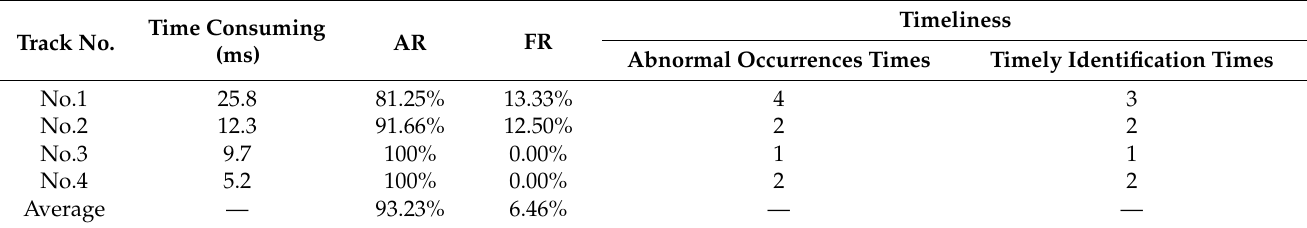
— — Table 13. Evaluation of ship trajectory anomaly detection results based on GRU.